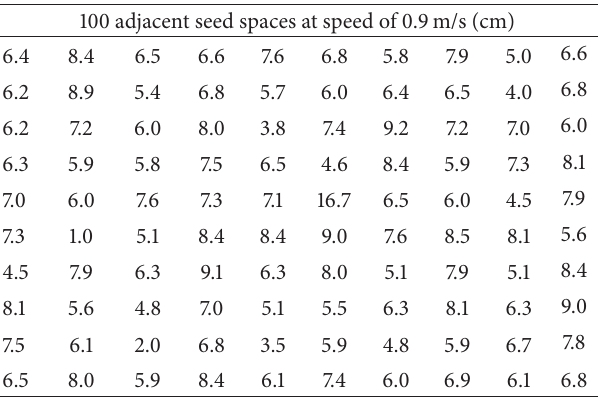
Table 6: Measured data at speed of 0.9 m/s.